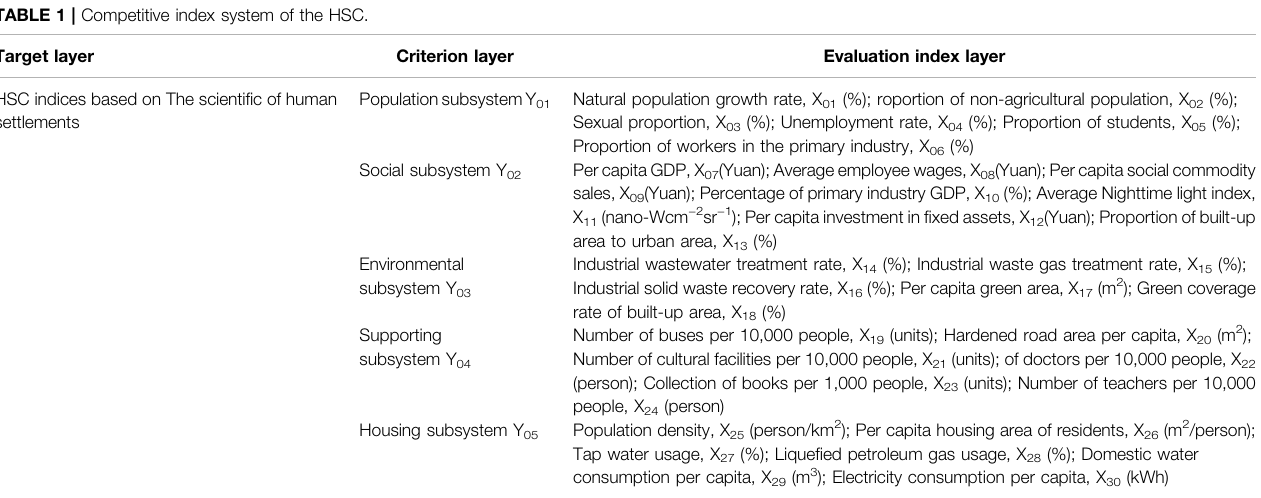
TABLE 1 | Competitive index system of the